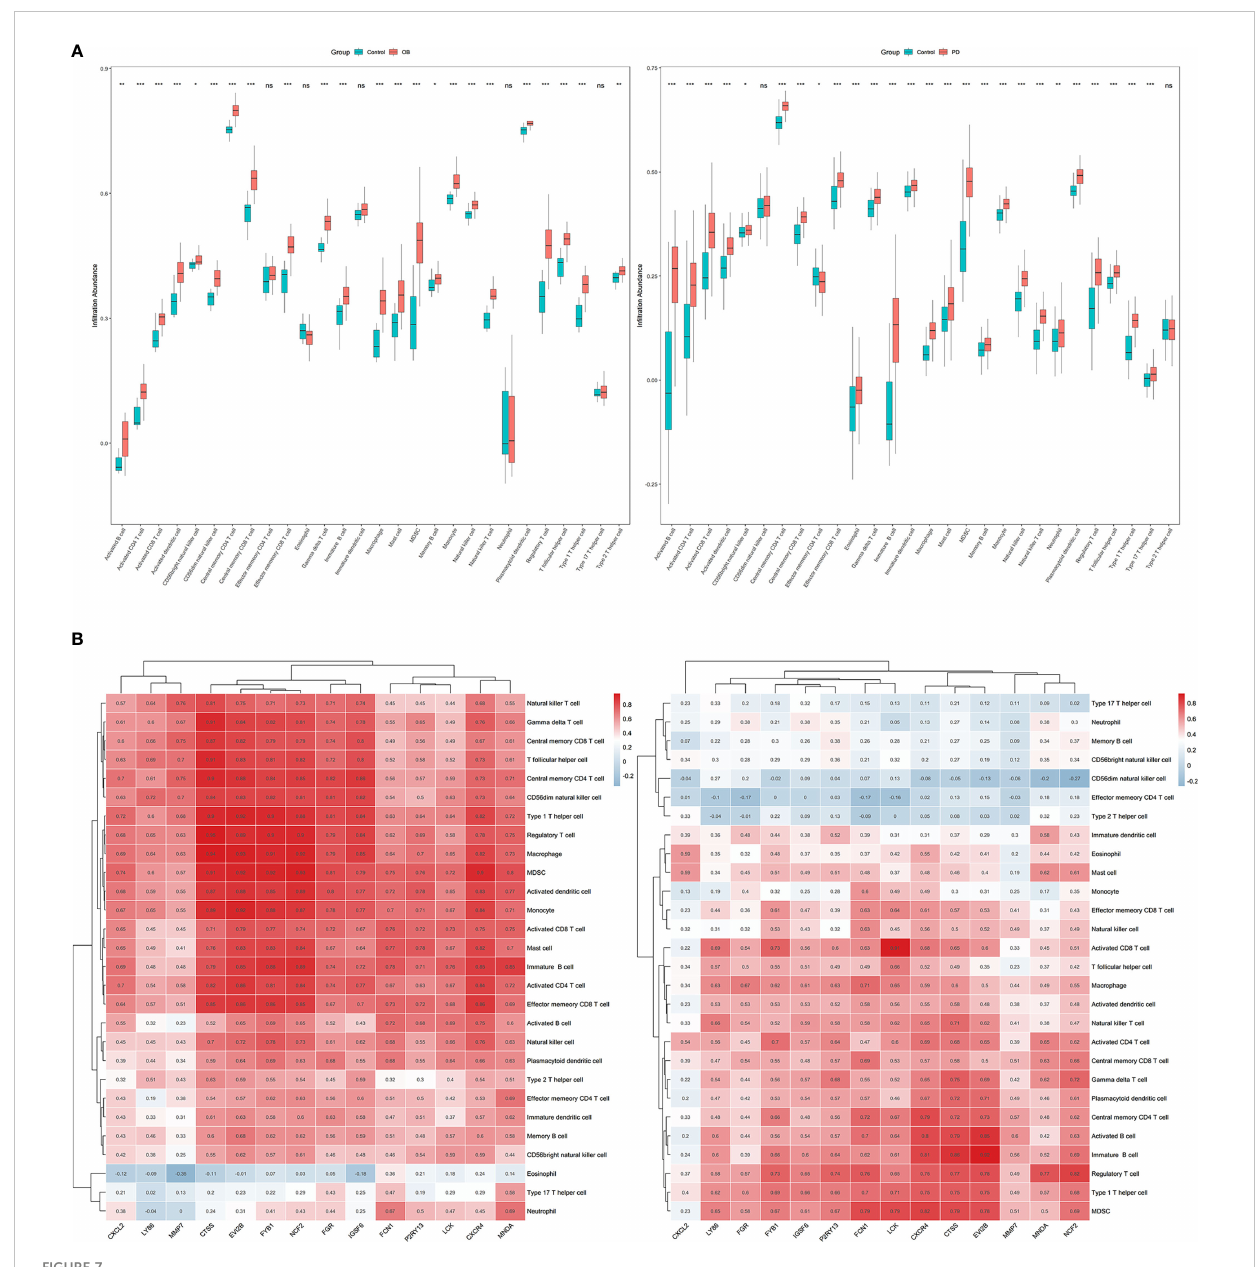
FIGURE 7 The results of immune in fi ltration analysis in obesity (OB) and periodontitis (PD) datasets. (A) Boxplots of the immune in fi ltration abundance in OB (left) and PD (right). (B) Heatmaps of the correlations between the 14 hub genes and the 28 immune cells in OB (left) and PD (right). * p <0.05, ** p <0.01, *** p <0.001, ns,